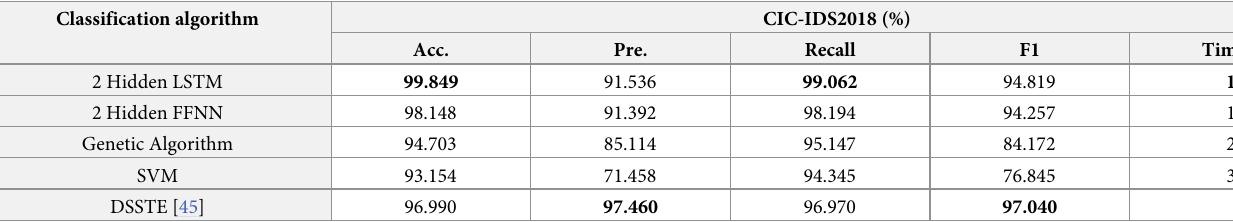
Table 9. CIC-IDS2018 Comparison results among different classifiers.